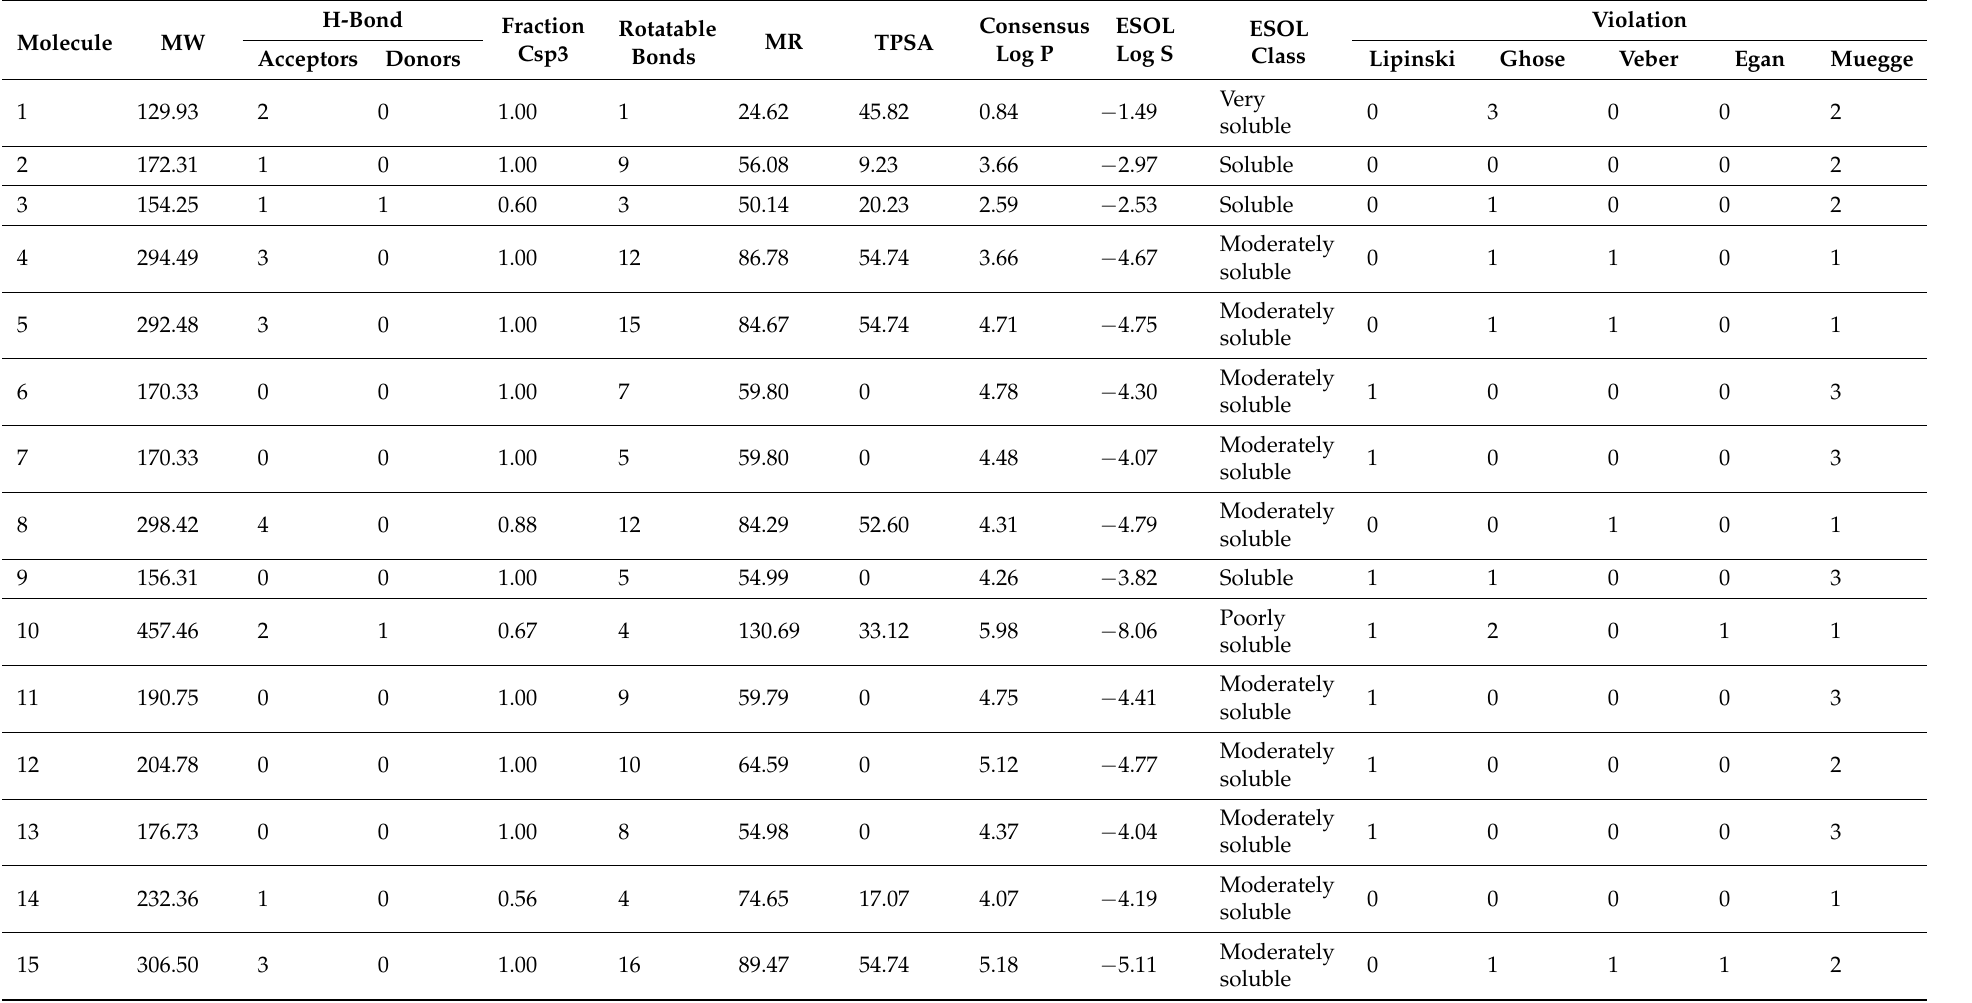
Table 4. Drug likeness results of the identified compounds from B. cernua. Nd: not